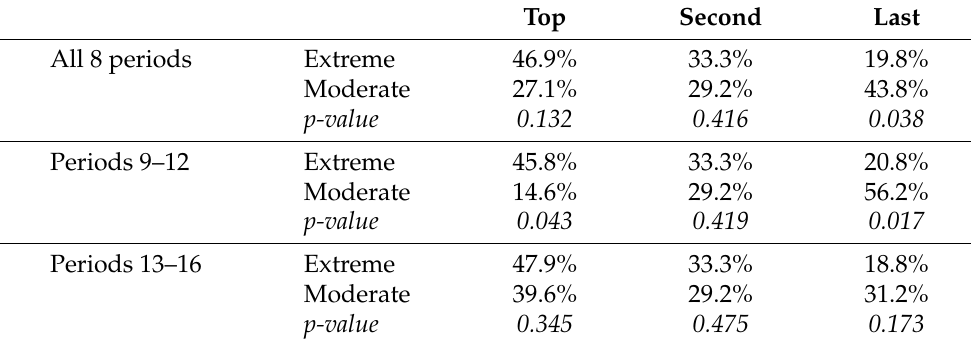
Table 2. Centrist’s vote share